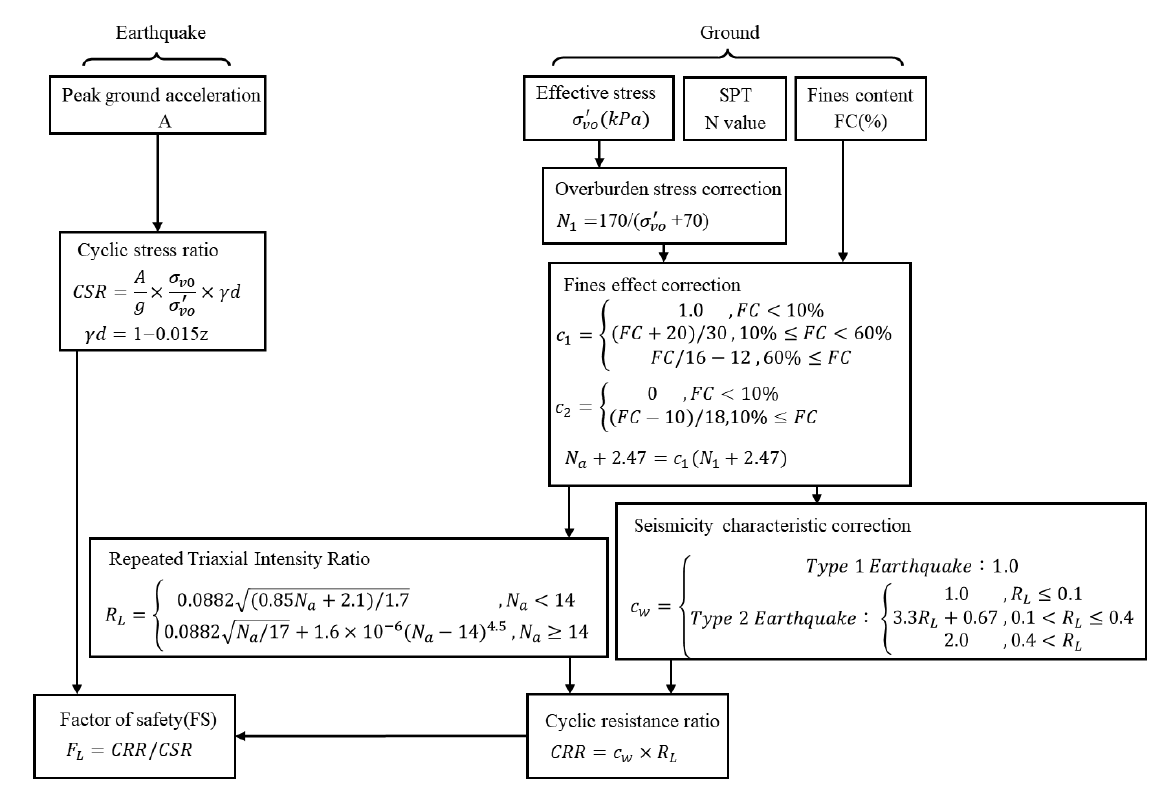
Figure 4. Analytical procedure of the JRA (2017) method [48,49].